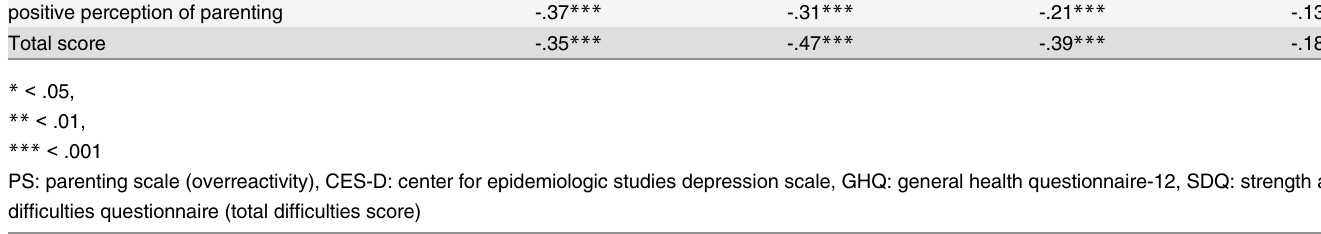
Table 4. The relationship of subscales and total score of PREQ with parenting style, psychological distress and the child ’ s behavior. PS CES-D GHQ SDQ knowledge of the child ’ s